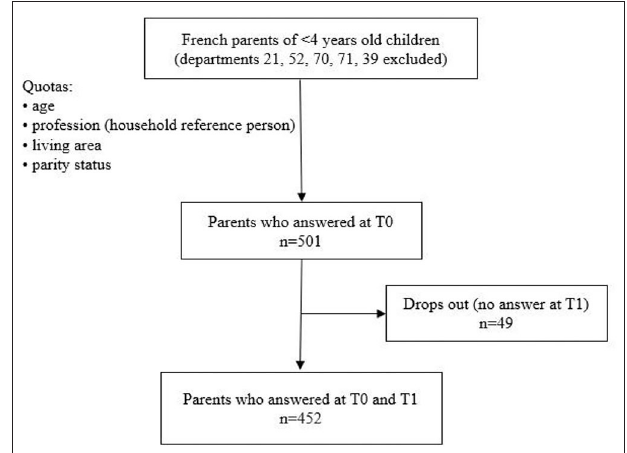
FIGURE 1 | Flowchart of the